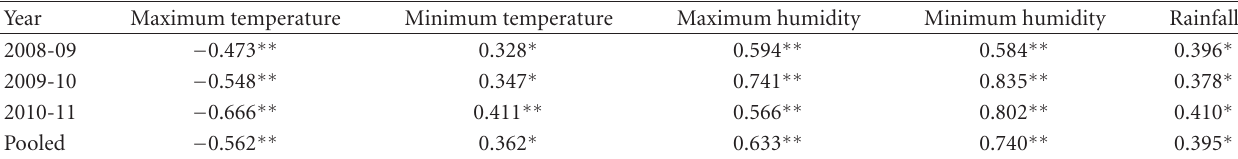
Table 2: Association of climatic factors with leaf roller infestation during 3